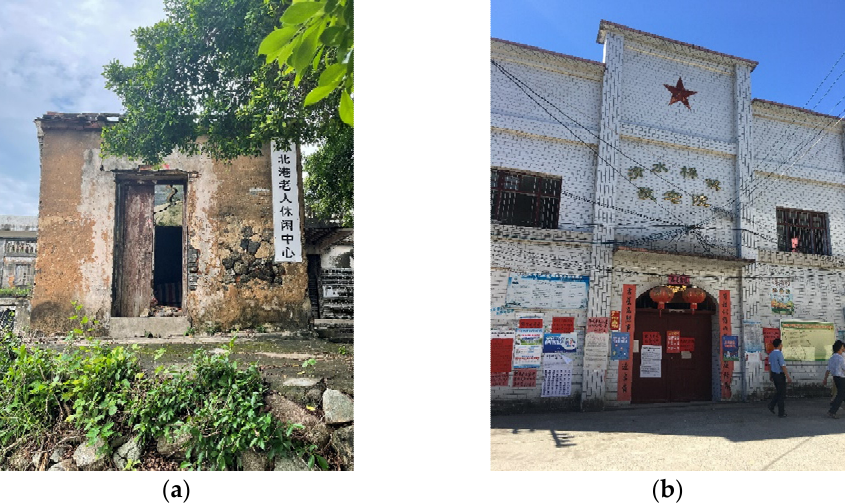
Figure 10. Abandoned village elderly activity center. ( a ) Scene of a village in Yangxi County, Guangdong Province; ( b ) scene of a village in Ningyuan County, Hunan Province (Source: by the authors).